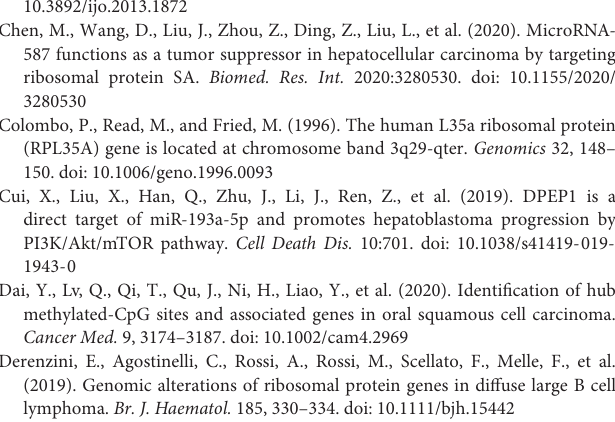
Supplementary Figure 1 | The 11 modules were enriched in 121 KEGG pathways. KEGG, Kyoto Encyclopedia of Genes and Genomes. Supplementary Figure 2 | Distribution of the co-expression network degree. Supplementary Figure 3 | Expression levels of the four hub genes in different stages of liver disease. (A) Expression level of RPL19 in different stages of liver diseases. (B) Expression level of RPL27A in different stages of liver diseases. (C) Expression level of RPL35A in different stages of liver diseases. (D) Expression level of RPS12 in different stages of liver diseases. ∗ P < 0.05, ∗∗ P < 0.01. Supplementary Figure 4 | Relationship between the expression levels of the four hub genes and the prognosis of HCC patients with different TNM stages. (A) Relationship between RPL19 expression and the OS and RFS of HCC patients according to TNM stage (stages I ∼ II and III ∼ IV). (B) Relationship between RPL27A expression and the OS and RFS of HCC patients according to TNM stage (stages I ∼ II and III ∼ IV). (C) Relationship between RPL35A expression and the OS and RFS of HCC patients according to TNM stage (stages I ∼ II and III ∼ IV). (D) Relationship between RPS12 expression and the OS and RFS of HCC patients according to TNM stage (stages I ∼ II and III ∼ IV). OS, overall survival. RFS, relapse- free survival. Supplementary Figure 5 | Overall survival curves of the immune infiltrating cells in HCC. Kaplan-Meier analysis showing the correlation between the immune cells scores and the OS of HCC patients. OS, overall survival. Supplementary Figure 6 | Progression free survival curves of the immune infiltrating cells in HCC. Kaplan-Meier analysis showing the correlation between the immune cells scores and the PFS of HCC patients. PFS, progress free survival. Supplementary Table 1 | All 31,334 genes identified. Supplementary Table 2 | All 7,814 DEGs. Supplementary Table 3 | Statistical results of genes corresponding to each module. Supplementary Table 4 | Distribution of 7,814 selected genes in the different modules. Supplementary Table 5 | Eleven modules were enriched in 121 KEGG pathways. Supplementary Table 6 | All genes whose co-expression values were greater than 0.1. Supplementary Table 7 | Eleven modules were enriched in 121 KEGG pathways. Supplementary Table 8 | Human PPI data from the HIPPIE database. Supplementary Table 9 | Human PPI